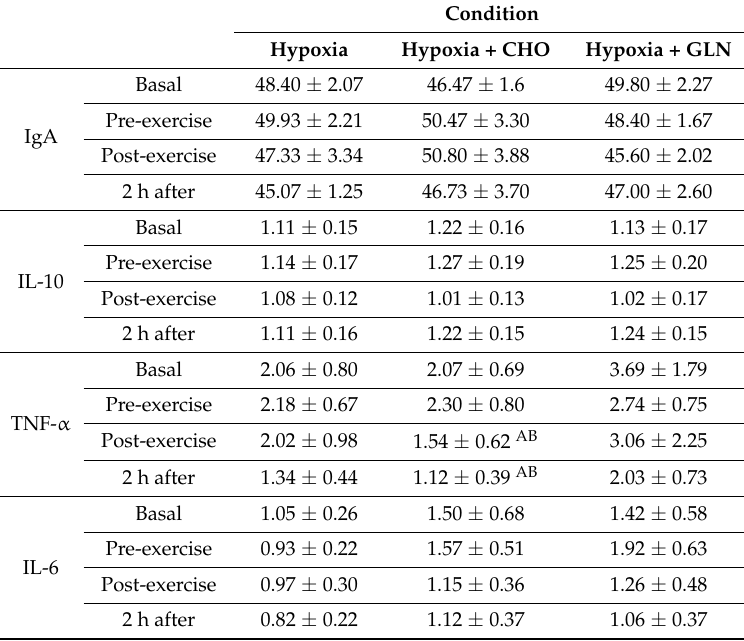
Table 3. IgA, IL-10, TNF- α e IL-6